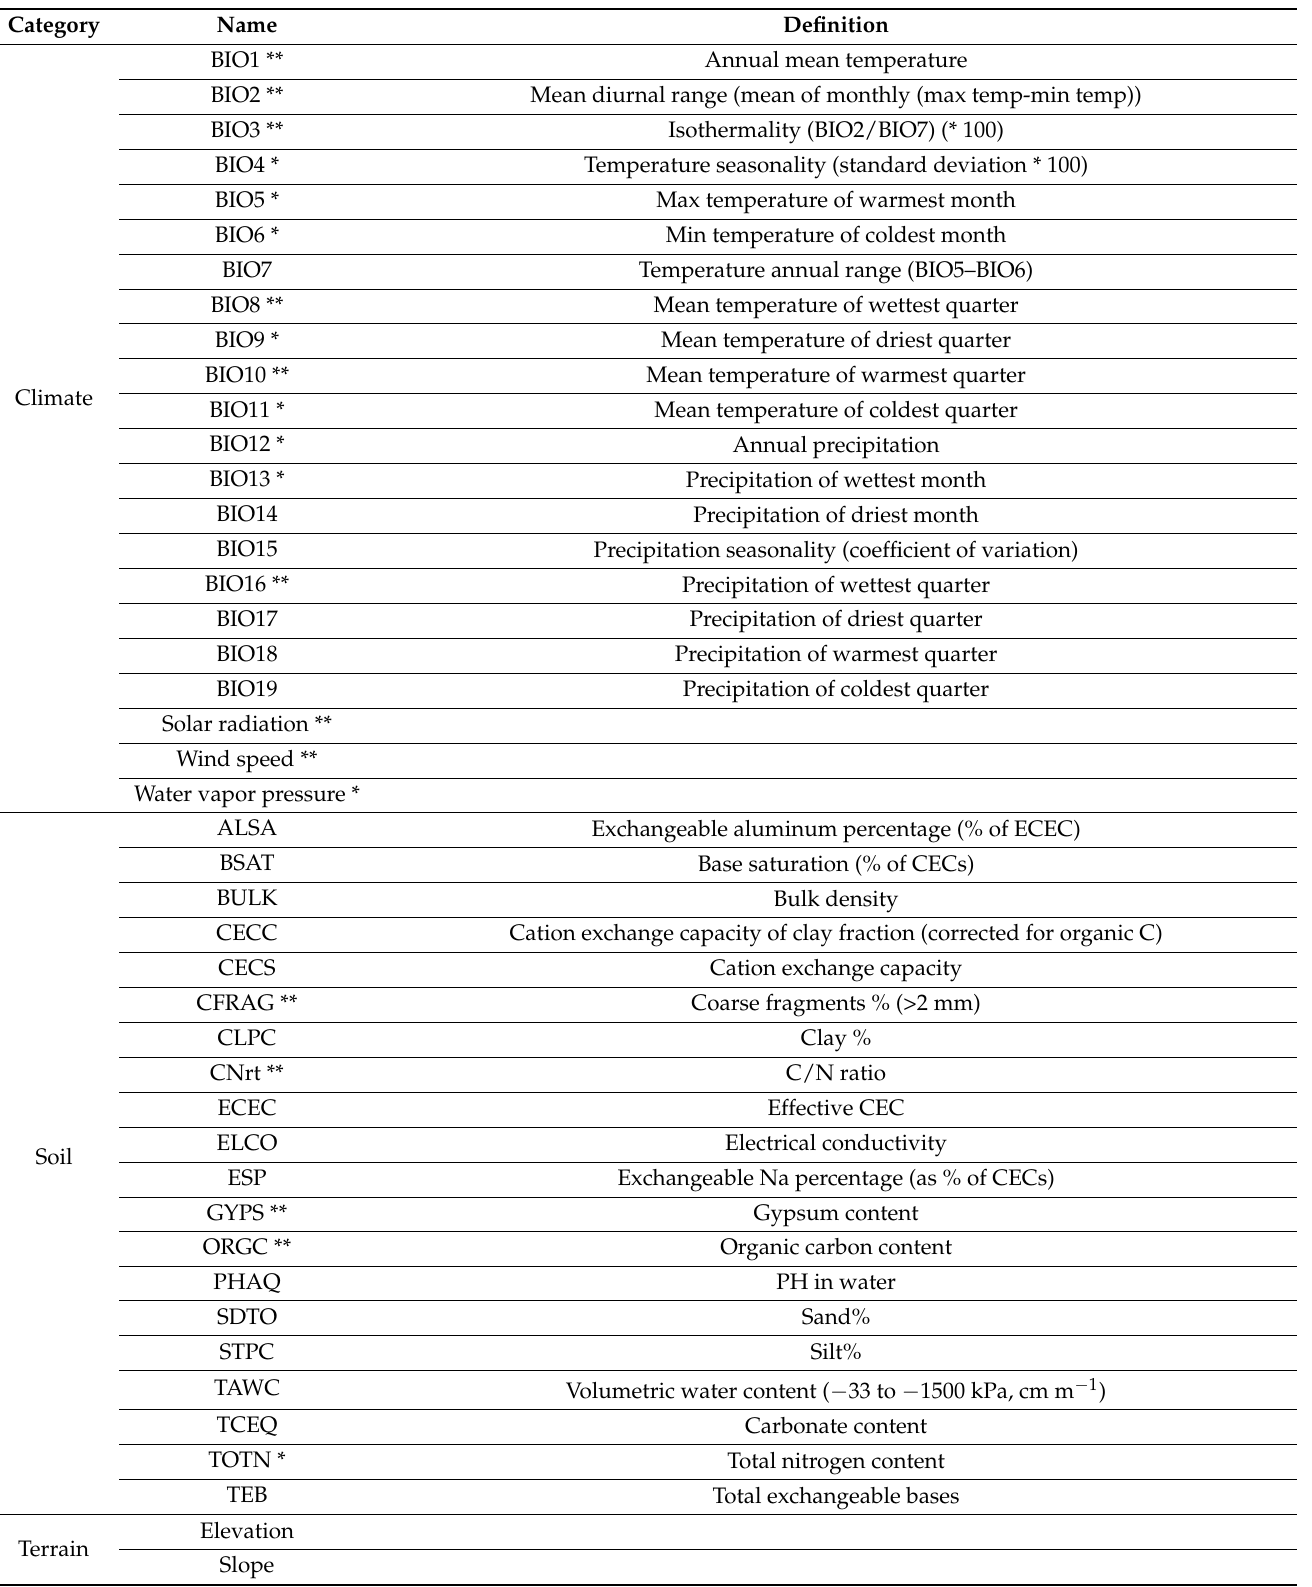
Table A2. The original and selected environmental